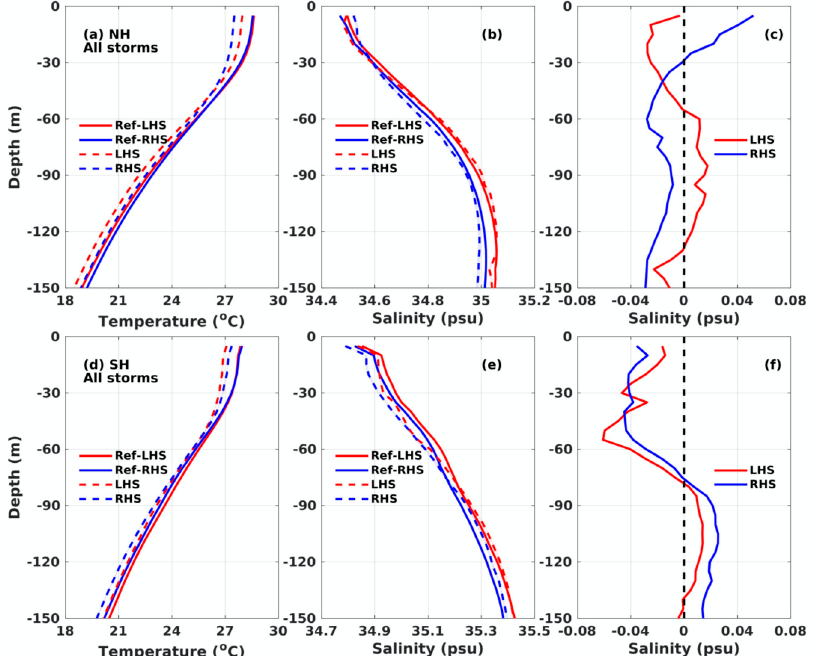
Figure 8. Composite temperature and salinity profiles during the reference time period (solid line) and averaged 1–5 days after the passage of the TCs (dashed line) for all storms during 2002 to 2019 in the Northern ( a , b ) and Southern ( d , e ) Hemisphere, with in-situ data from Argo floats. The salinity difference between the composite average during reference time period and days 1 to 5 in the Northern and Southern Hemisphere is presented in ( c ) and ( f ), respectively. LHS (RHS) shows the composite profiles within the left (right) 2° × 1° box of the center. Color shading indicates the standard error of each variable.